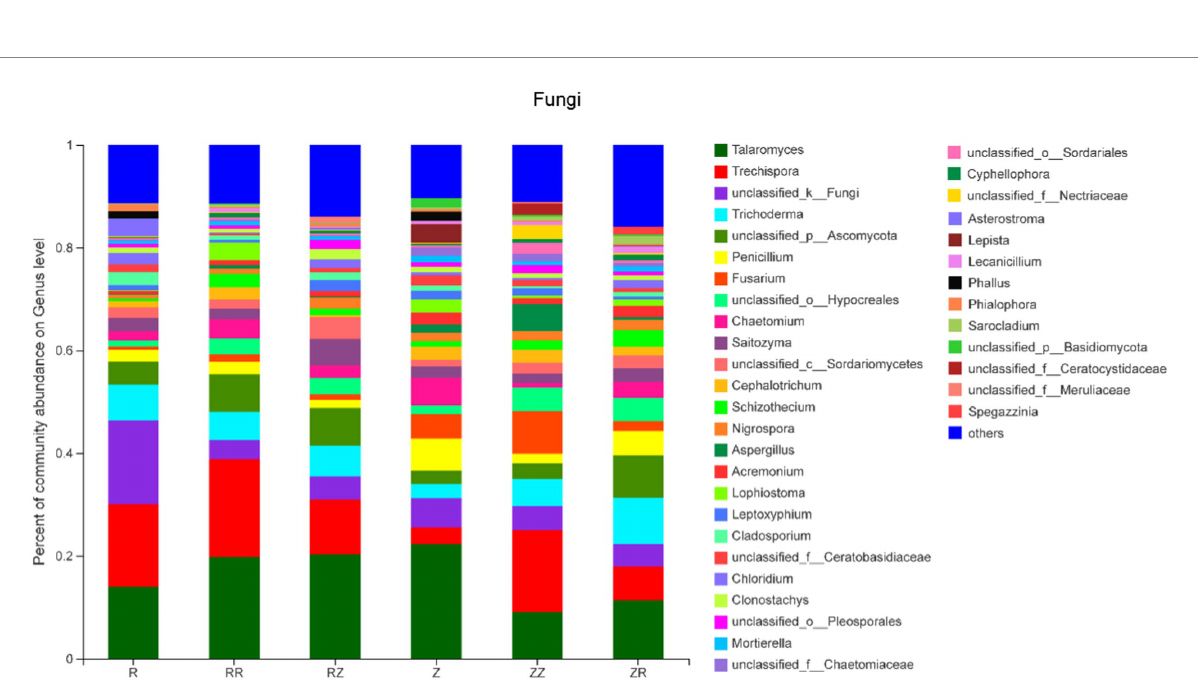
FIGURE 3 Response of sugarcane straw returning on the relative abundance (% total reads) of fungal community at genus level of different sugarcane cultivars. R: cultivar ROC22, RR: cultivar ROC22 plus straw of ROC22; RZ: cultivar ROC22 plus straw of Zhongzhe9; Z: cultivar Zhongzhe9; ZZ: cultivar Zhongzhe9 plus straw of Zhognzhe9; ZR: cultivar Zhongzhe9 plus straw of ROC22. ‘Other’ was the sum of genera that relative abundance was lower than